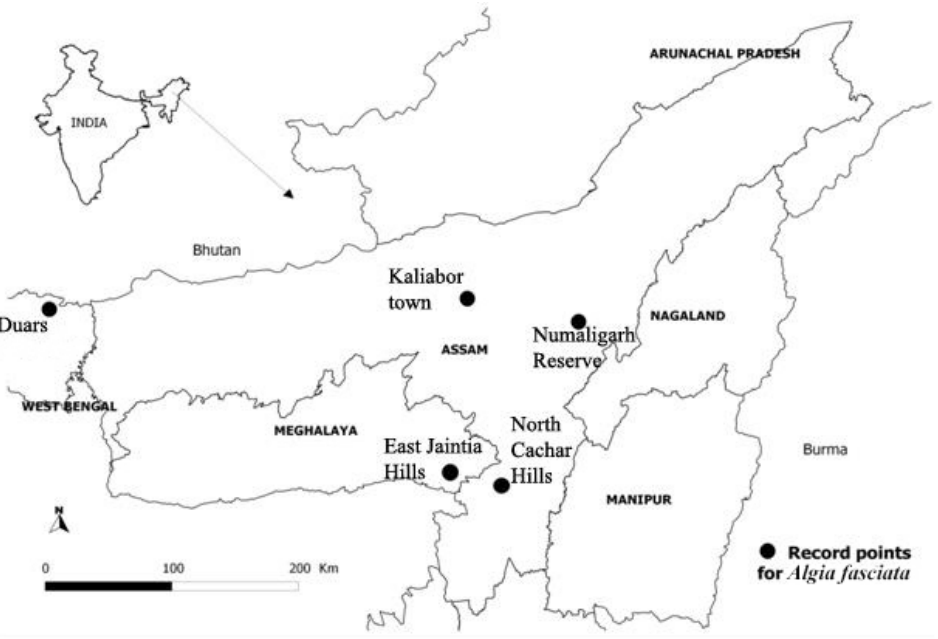
Figure 1. Map showing recent records of Algia fasciata fasciata in northeastern